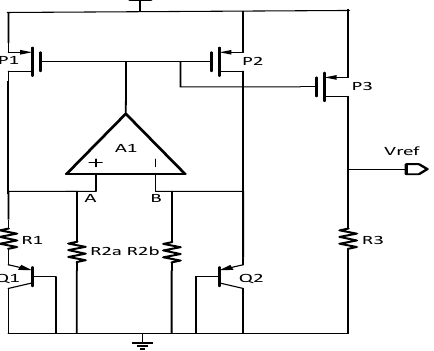
Figure 1. Bandgap reference with current mode structure. P represents PMOSFET; R represents resistance; Q represents transistor.